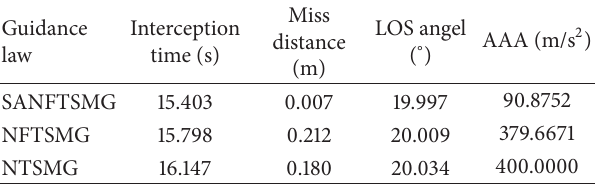
Table 3: Summary of simulation results in Case 2 .